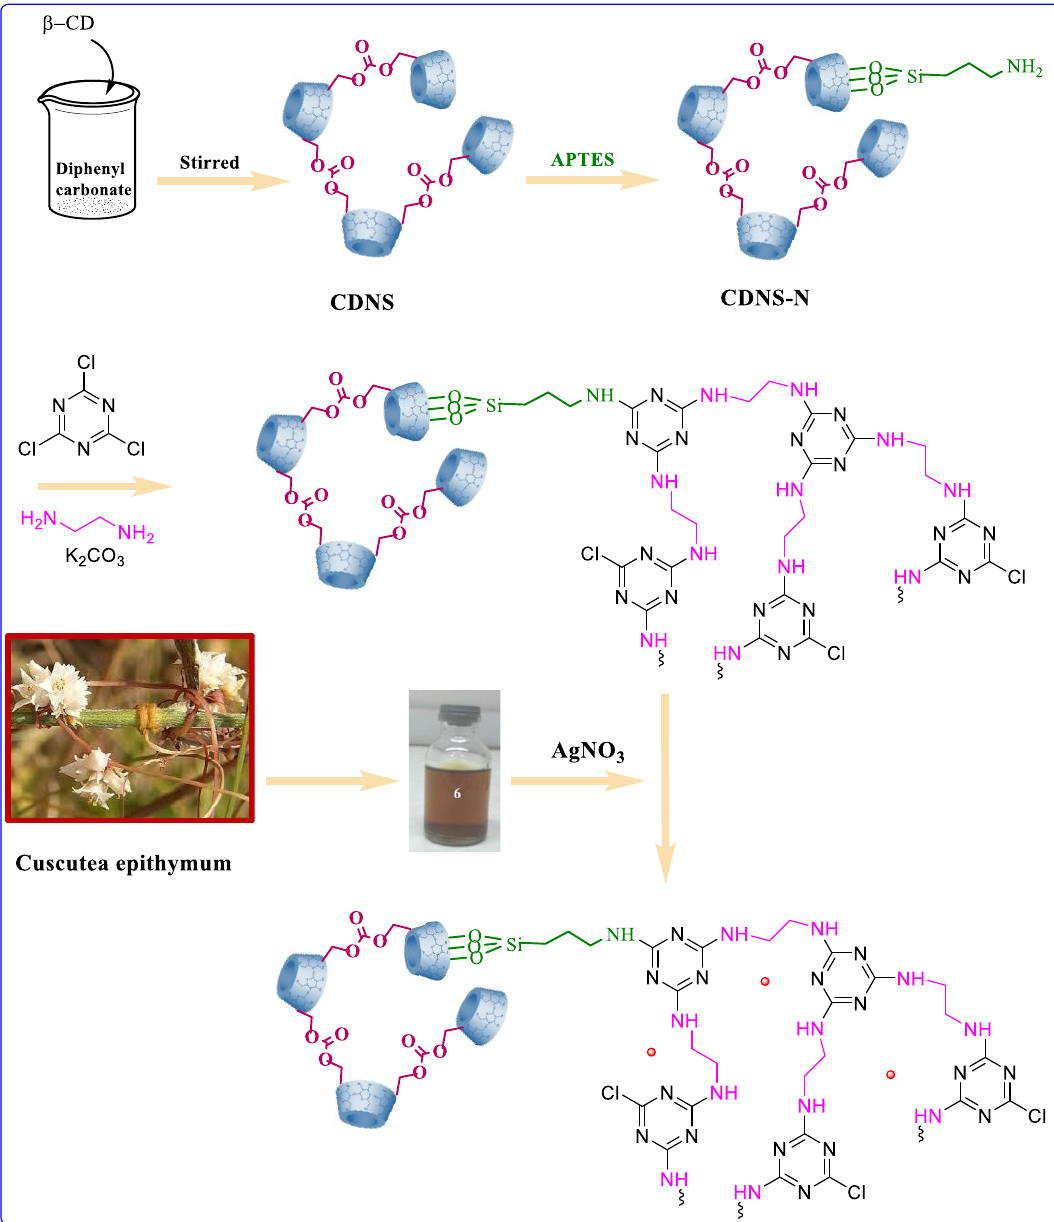
Figure 11. The schematic procedure of the synthesis of the proposed structures.